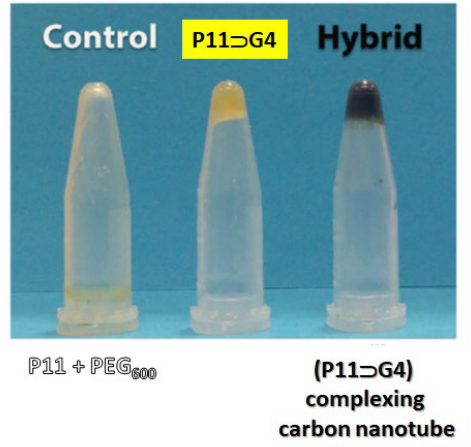
Figure 3. Photographs of pillar[5]arene-based polymer-carbon nanotube-complexed organogels in 1,2-dichlorobenzene via noncovalent interactions ( right ), compared to those phenomena in the presence of P11 ⊃ G4 ( middle ), as well as physical mixture of P11 and PEG600 [85]. Copyright © 2022 by American Chemical Society.